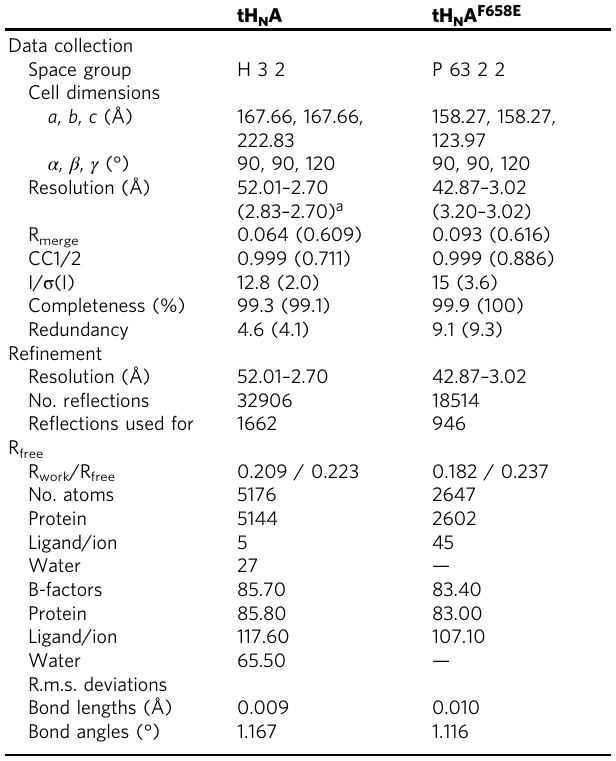
Table 1 Data collection and re fi nement